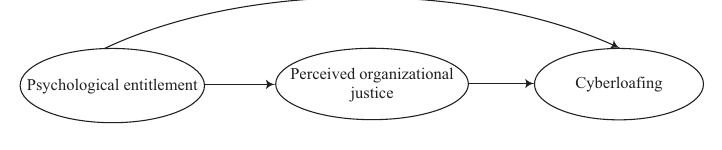
Figure 1. Research conceptual